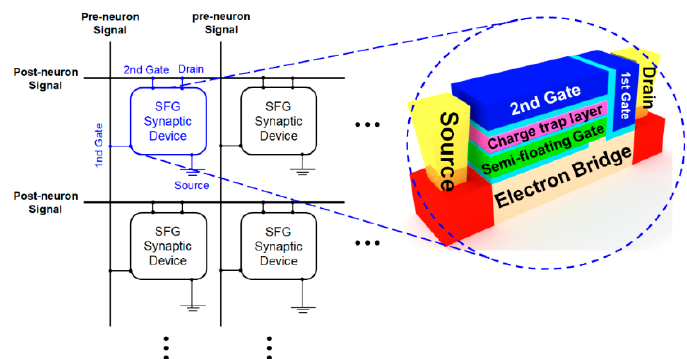
Figure 8. Array architecture for the artificial spike neural network (SNN) based on the proposed SFGST device with the full accommodation of the developed bias schemes.